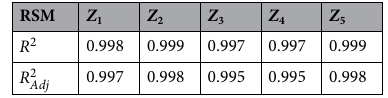
Table 4. Fitting effect of RSM.